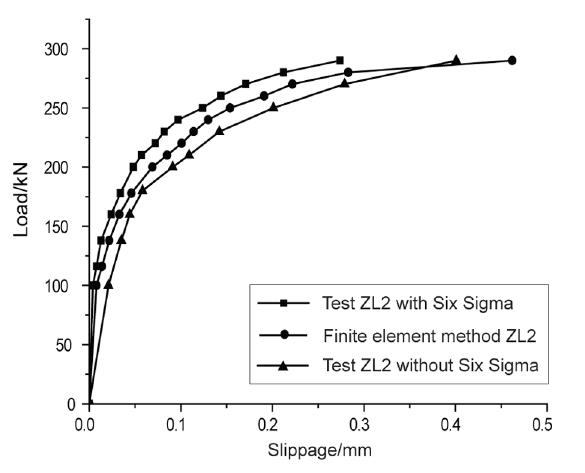
Fig. 8. Load-slip curves 2